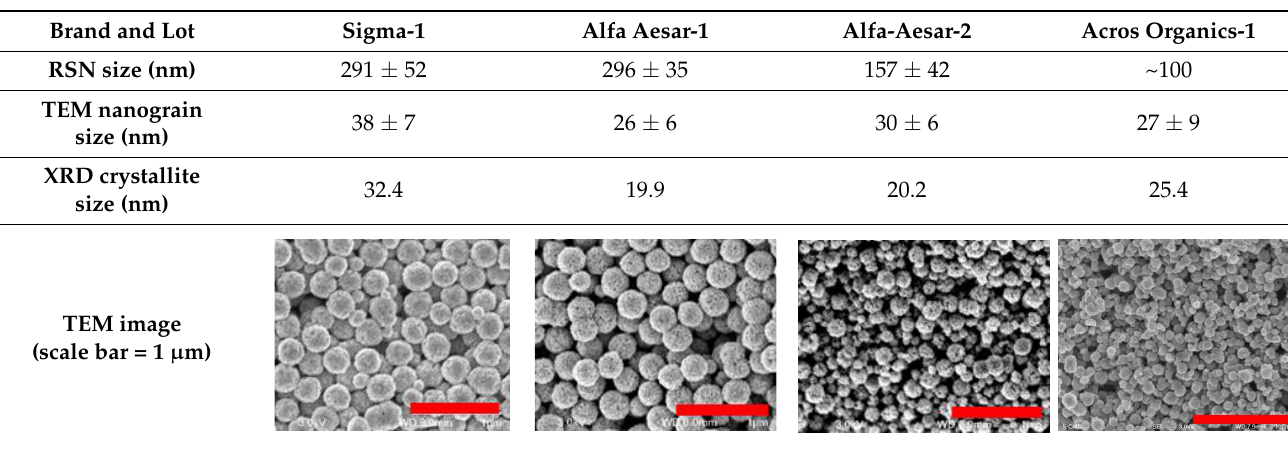
Table 2. Mean crystallite size (deduced from XRD patterns) and mean diameter and nanograin size of RSNs as a function of the used iron precursor and representative SEM images of the synthesis.